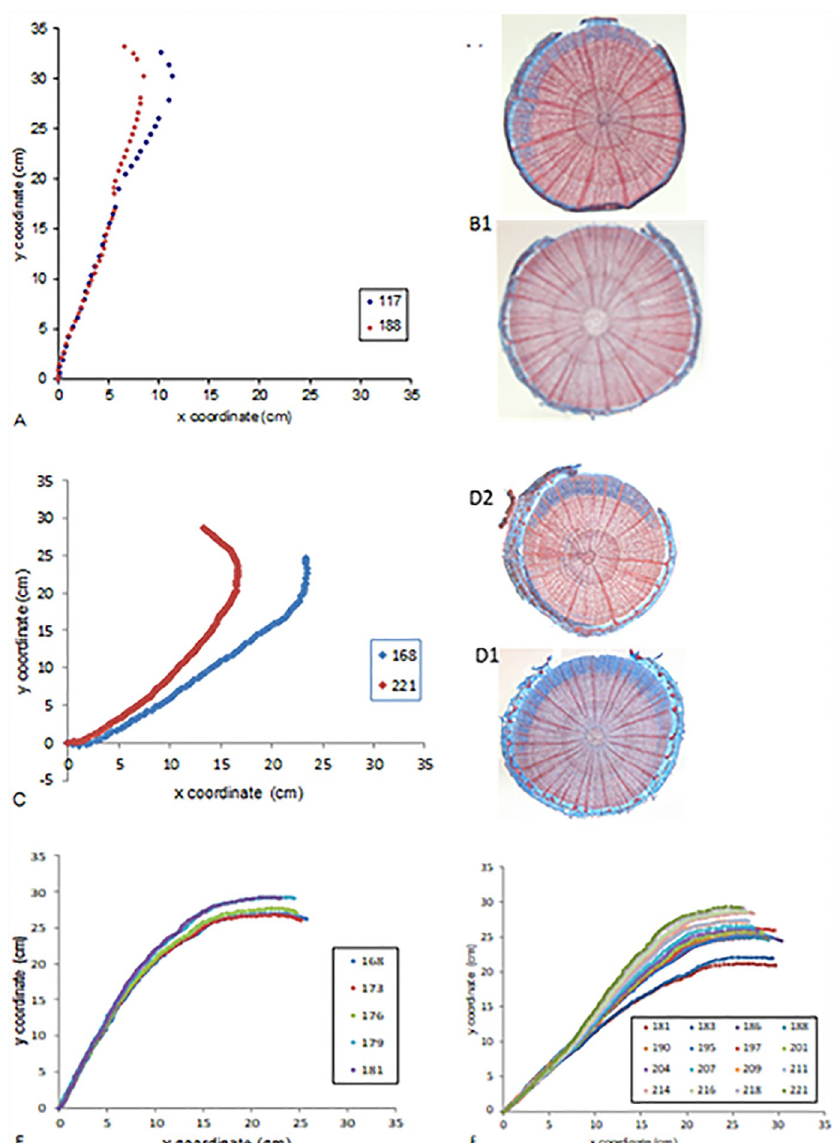
Fig 6. Shapes of beech trees just after tilting and at equilibrium, in an isotropic light environment. A: Pots were tilted 20˚ from the vertical. No movement could be detected except at the top of the stem (annual shoot), which was tilted more than 20˚. B: Photos of anatomical double-stained transversal sections of the stem: B1: Section cut between 0 and 10 cm from the stem base: no reaction wood can be detected; B2: Section cut in the upper part of the stem below the annual shoot: a sector of reaction wood can be detected (crescent stained blue). C: Pots were titled 45˚ from the vertical. Tree exhibited a visible upward movement. D: Photo of anatomical double-stained transversal sections of the stem. D1: Section cut between 0 and 10 cm from the stem base: a sector of reaction wood can be detected. D2: Section cut in the upper part of the stem below the annual shoot: a sector of reaction wood can be detected. E: Pot was tilted 20˚ from the vertical for two weeks. The shapes of the stem during the two weeks of tilting are represented; dates are indicated on the graph (Julian days). Almost no movement can be detected. F: The tree was first tilting 20˚ from the vertical (shown on E) and then the tilting was increased to 45˚. Stem shapes until gravitropic equilibrium are presented at the different dates indicated on the graph. The stem uprighted itself.